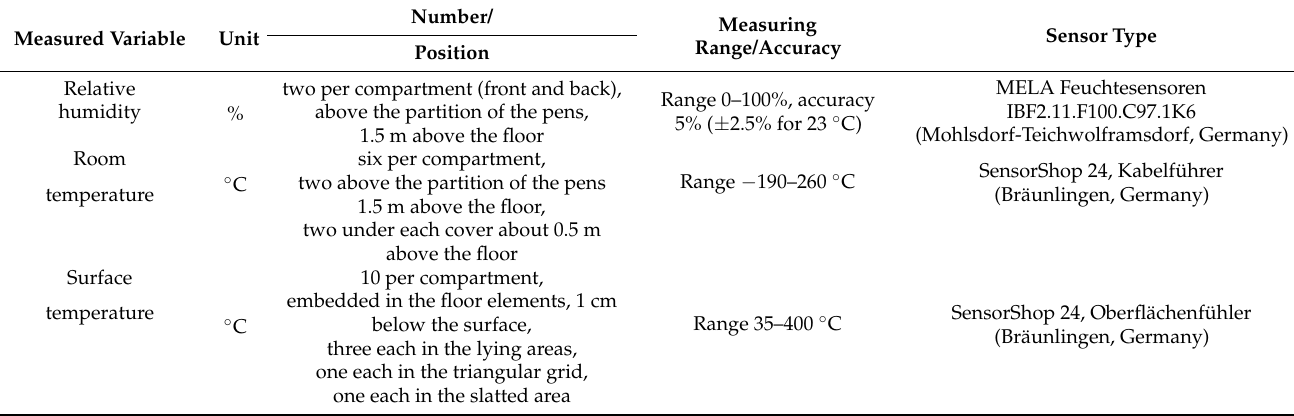
Table 2. Overview of the sensors used in this study. All sensors recorded data every minute. Measured Variable Unit